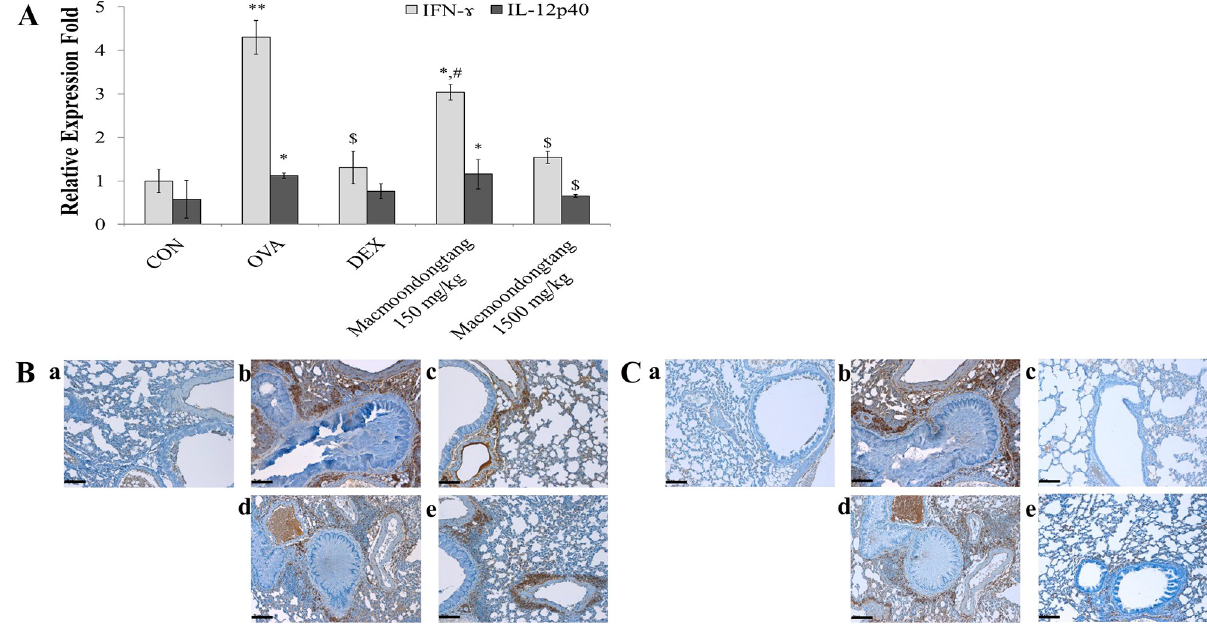
Fig 6. Treatment with macmoondongtang significantly down-regulated gene and protein expression of IFN- γ and IL-12p40. Macmoondongtang dose-dependently controlled both IFN- γ gene expression quantified by RT-PCR (A) and IFN- γ protein levels assessed by IHC (B). Macmoondongtang also regulated IL-12 gene expression and up-regulated gene and protein expression of IL-12p40 in the lung (C). a , vehicle control; b , asthma induction; c , dexamethasone; d , 150 mg/kg/day macmoondongtang ; e , 1500 mg/kg/day macmoondongtang . Each bar represents the mean ± SD (n = 8). � p < 0.05 vs. control; �� p < 0.001 vs. control; $ p < 0.05 vs. asthma induction; # p < 0.05 vs. dexamethasone. Scale Bar = 50 μ m. Magnification, × 200.